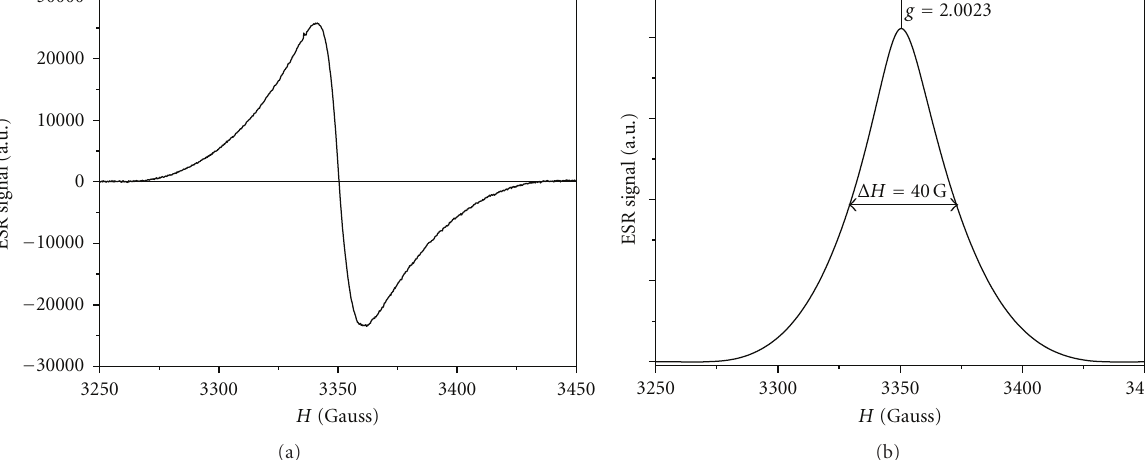
Figure 4: ESR spectrum of Ag-treated SWCNT taken at 6K. (a) First derivative (b)